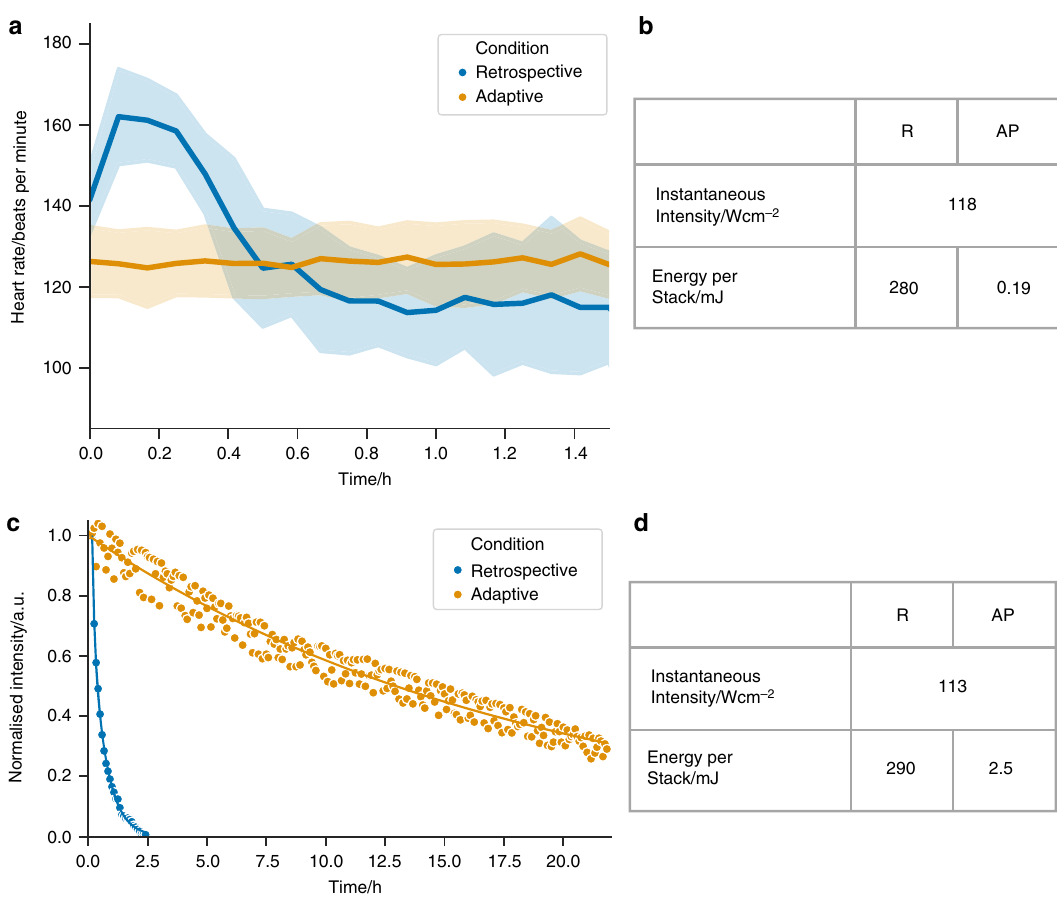
Fig. 5 Adaptive prospective optical gating minimises cardiac photo-injury and photobleaching. a Acquisition of multiple fl uorescent z -stacks in a zebra fi sh heart (transgene myl7 :GFP; 3 dpf) using a retrospective optical gating protocol (blue; mean (line) with standard deviation (band)) causes an increase, followed by a fall, in heart rate over a 1.6 h imaging period ( n ¼ 6 fi sh). Meanwhile 1.6 h of continuous image acquisition using our adaptive